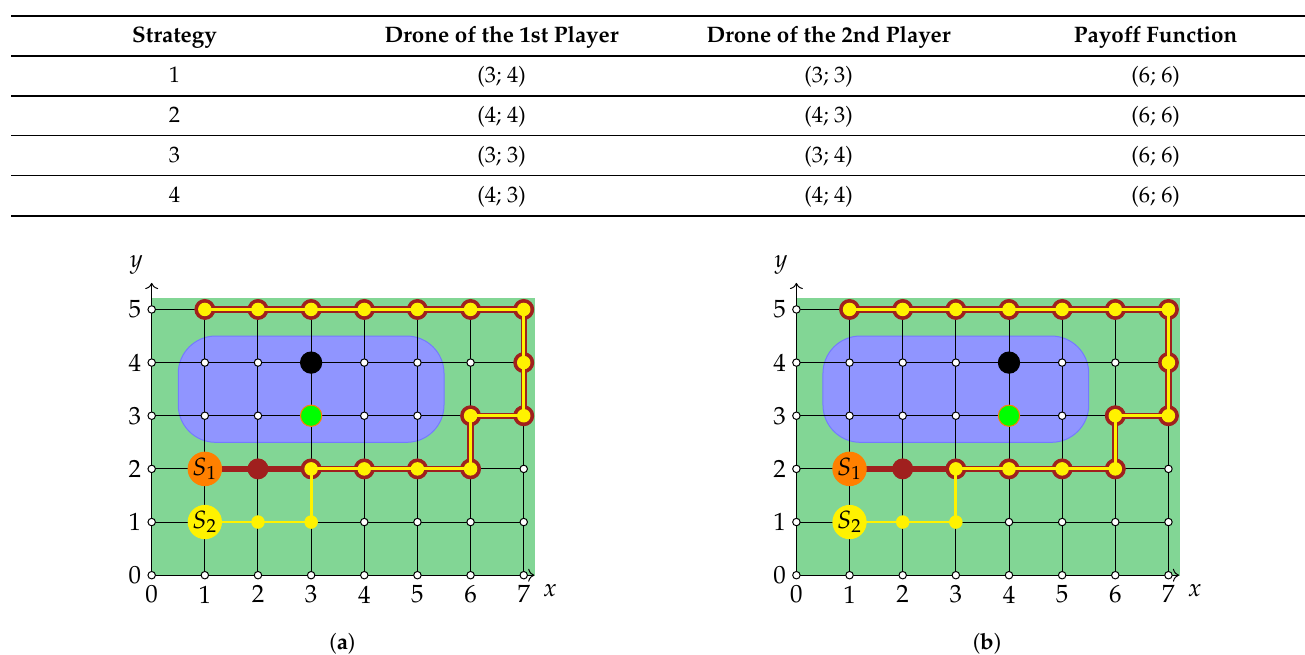
Table 1. Optimal strategies: Network 1.